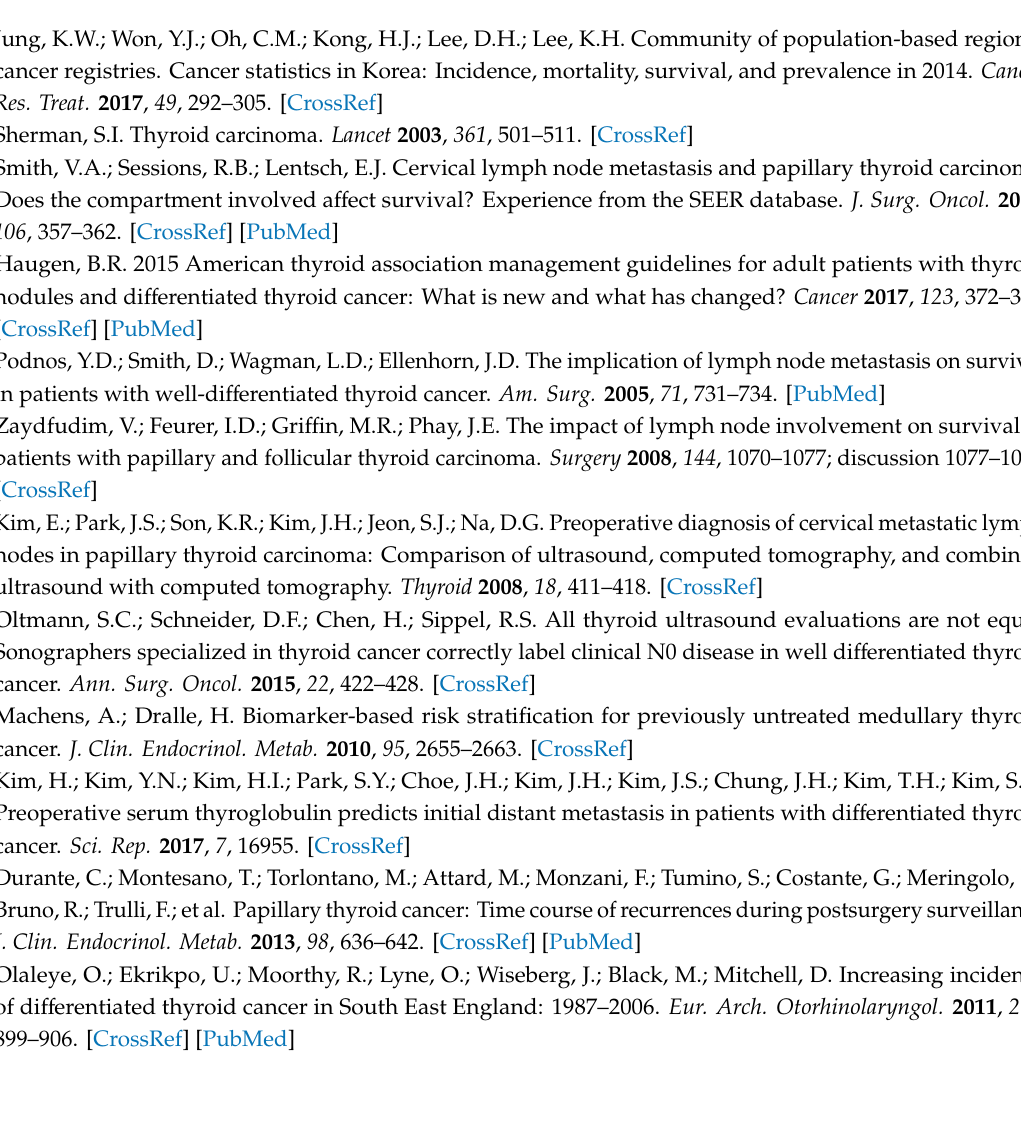
Figure S1: Correlation between tumor burden and preoperative thyroglobulin levels in patients with papillary thyroid carcinoma, Figure S2: Correlation between tumor burden and preoperative thyroglobulin levels in patients with follicular thyroid carcinoma, Figure S3: Correlation between tumor extent and preoperative thyroglobulin levels in patients with papillary thyroid carcinoma, Figure S4: Correlation between tumor extent and preoperative thyroglobulin levels in patients with follicular thyroid carcinoma, Table S1: Tumor burden and cancer prognosis by preoperative serum thyroglobulin levels in patients with papillary thyroid carcinoma, Table S2: Tumor burden and cancer prognosis by preoperative serum thyroglobulin levels in patients with follicular thyroid carcinoma, Table S3: Tumor extent by preoperative serum thyroglobulin levels in patients with papillary thyroid carcinoma, Table S4. Tumor extent by preoperative serum thyroglobulin levels in patients with follicular thyroid